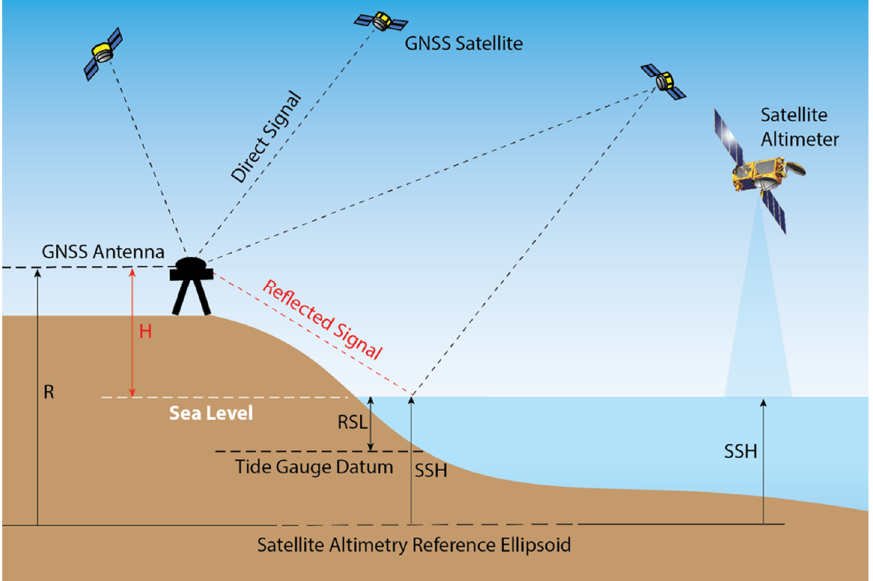
Figure 1. Schematic of coastal land-based GNSS, tide gauges and satellite altimeter measurements. The land-based GNSS receiver records the phase of the electromagnetic wave of the GNSS signal, and this signal arrives both directly from the satellite and from reflections off the nearby water surface. Those two signals interfere with each other, creating a characteristic oscillating pattern overlain on a long-term trend in the SNR data. By analyzing the frequency of the SNR oscillation in low elevation angle data, we can estimate the vertical distance (H) from the water surface to the GNSS antenna phase center. Additionally, the precise position of the antenna reference point (R) can be obtained through the analysis of direct carrier phase signals. Combining results from the direct and the reflected signals, we then obtain sea surface height above the satellite altimetry reference ellipsoid (SSH = R − H) as long as the offset between the geodetic antenna reference point and the reflection phase center is